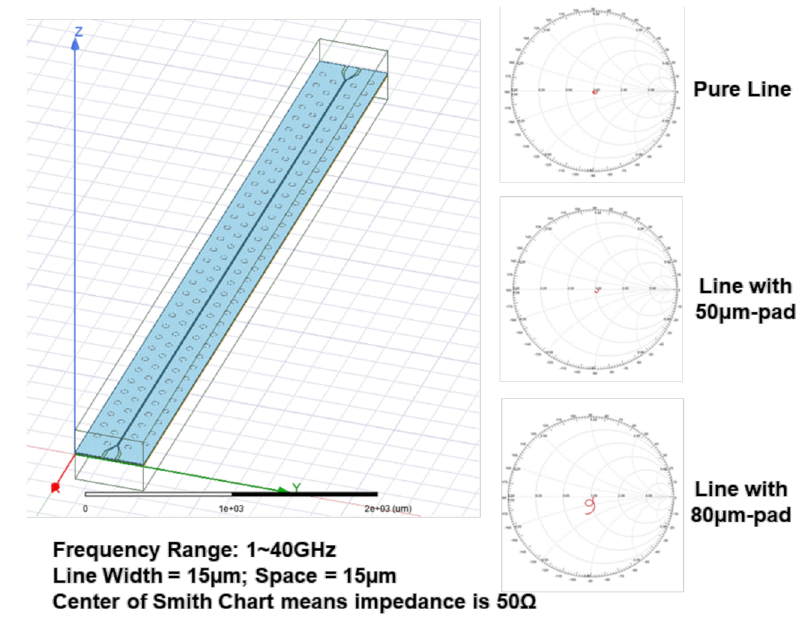
Figure 10. ANSYS HFSS model and Smith charts.